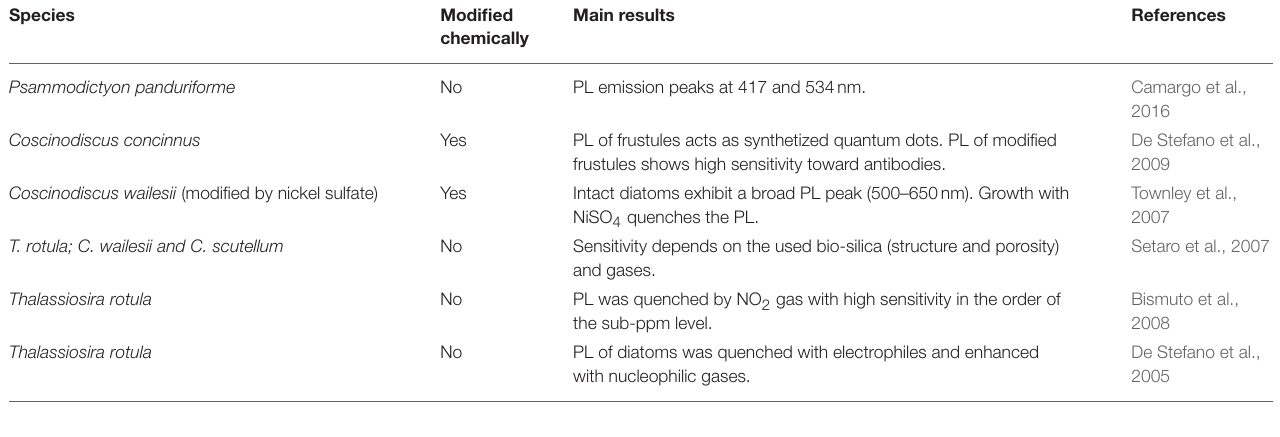
TABLE 2 | Photoluminescence studies on diatom frustules.